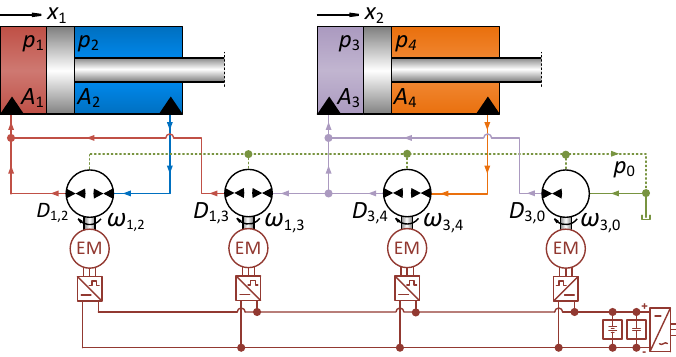
Figure 12. Schematic for VDN-L with interconnection scheme 2 ↔ 1 ↔ 3 ↔ 4, 0 ↔ 3.